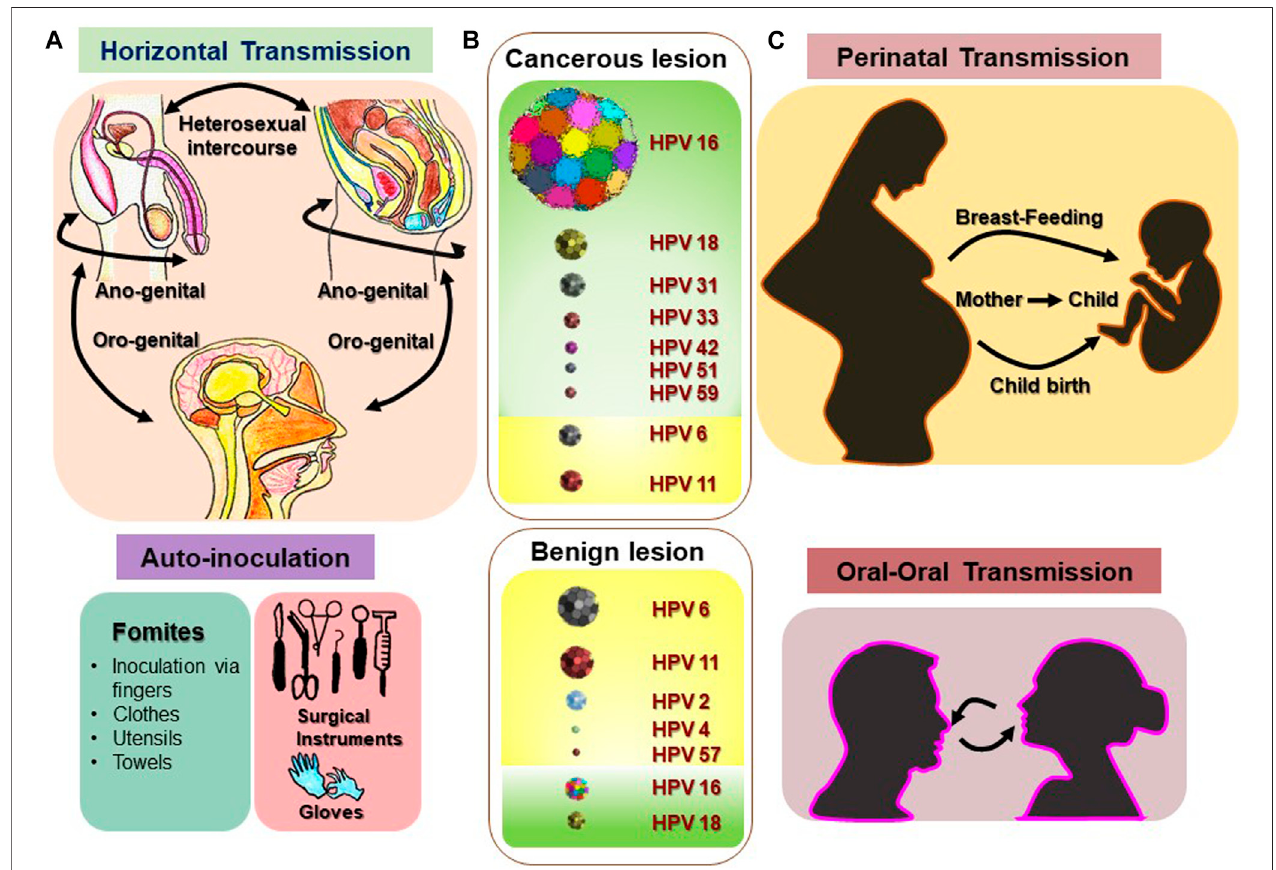
FIGURE2| VariousroutesandsitesofHPVtransmission.HPVisasexuallytransmittedinfectionthatcanbereceivedthroughhorizontaltransmission(heterosexual intercourse, anogenital, and oro-genital) and in some rare cases through various fomites, and inoculation via fi ngers, clothes, utensils, towels, and surgical instruments. (A) Vertical transmission (perinatal transmission: mother to baby) and oral – oral transmission of HPV could be the main source of nonsexual transmission of HPV in oral sites. (C) Mostprevalenthigh-riskandlow-riskHPVtypesreportedinbenignandmalignantlesionsoftheHNregionaredepictedwithrepresentative fi gureswhere the relative frequency of the each type is indicated with corresponding sizes. (B) [Disclaimer: Pictures used to make composite diagram and to represent HPV types are derived from different internet sources and does not claim to be the original representation of the indicated HPV type] (Sarkola et al., 2008; Chaturvedi et al., 2015; Fu et al., 2015; Visalli et al., 2016; Louvanto et al., 2017; Sabeena et al., 2017; Syrjanen, 2018; Houlihan et al., 2019).